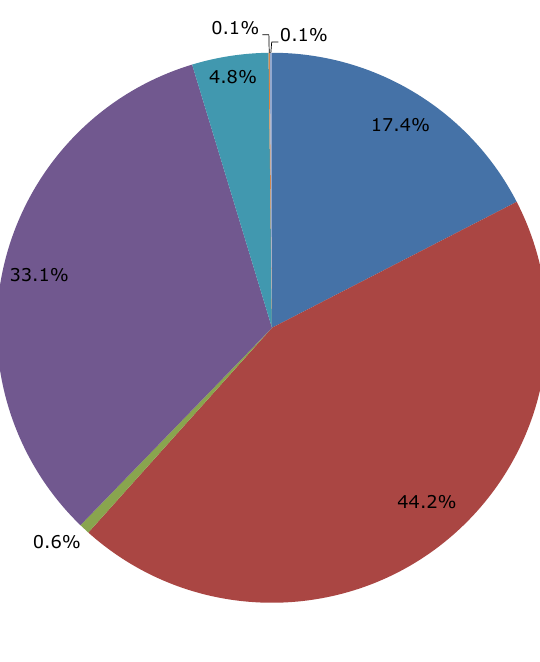
Figure 53: NBV of Tangible Fixed Assets of the six largest suppliers’ generation plants (2012) by plant